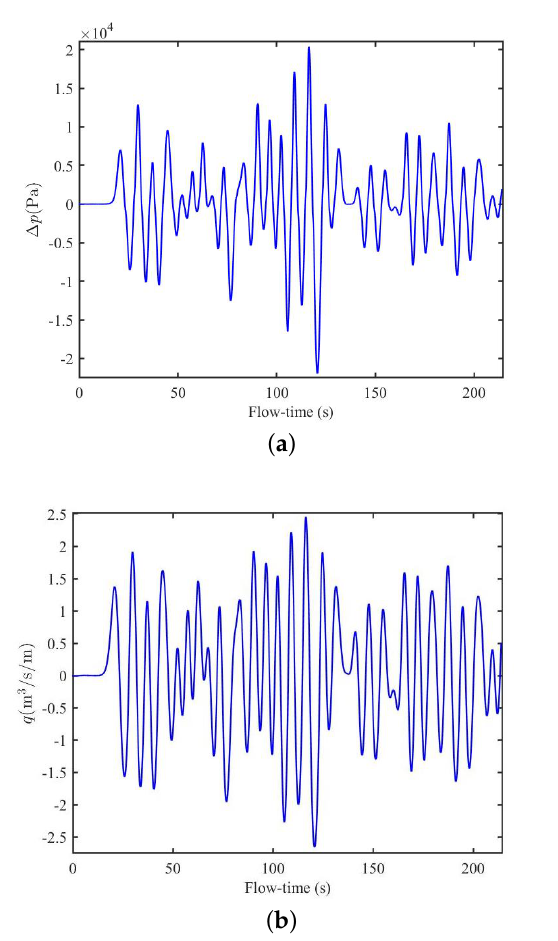
Figure 19. Variation in the ( a ) pressure drop, and ( b ) flow rate vs. the flow-time, with H s = 1.88 m and ω p = 0.993